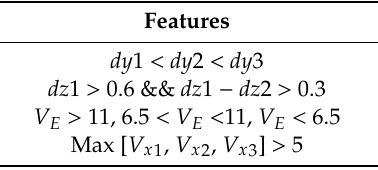
Table 1. Hand state characteristics.